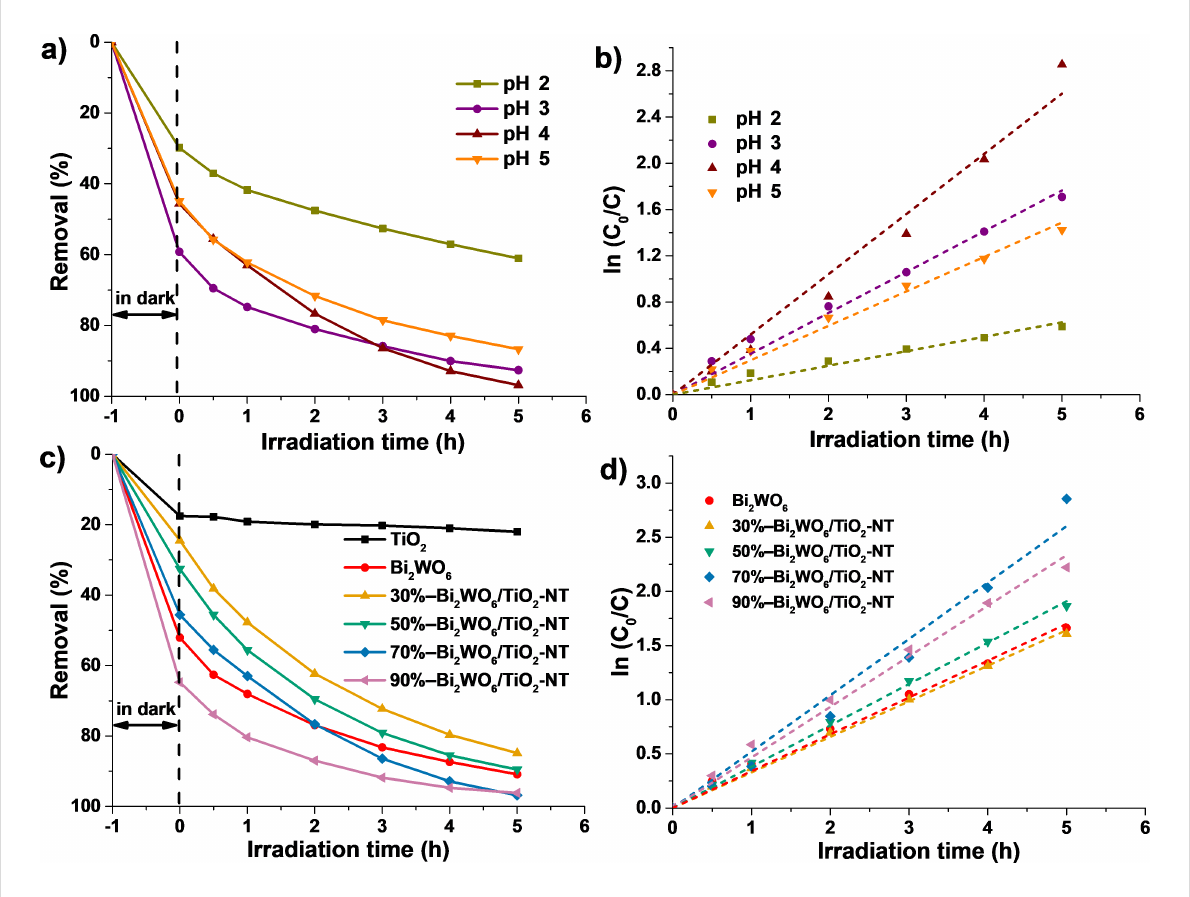
Figure 7: (a) Visible-light-induced ( λ > 420 nm) photocatalytic reduction profiles toward the Cr(VI) pollutant solution (10 mg·L − 1 ) under various pH conditions by the hierarchical 70% − Bi 2 WO 6 /TiO 2 -NT nanocomposite. (c) Visible-light-induced ( λ > 420 nm) photocatalytic reduction profiles toward the Cr(VI) pollutant solution (10 mg·L − 1 , pH 4) by different samples, as well as (b,d) the corresponding linear fitting curves based on the pseudo-first- order kinetic